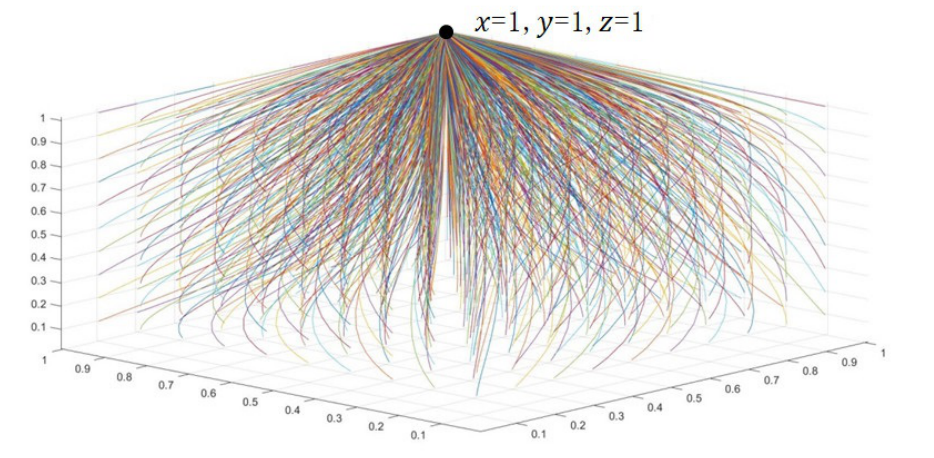
Figure 1. Path of numerical